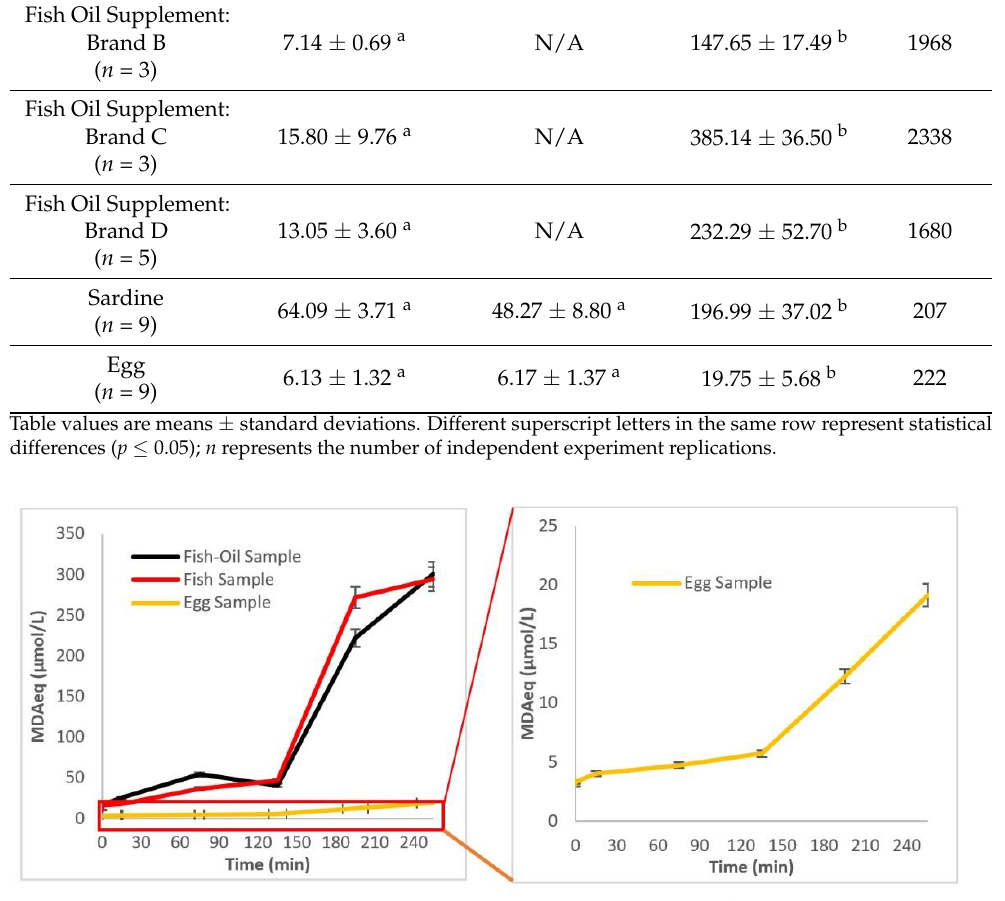
Figure 2. Effect of the GI tract on secondary oxidation of ( a ) fish-oil supplement—Brand D; sardine; fortified egg ( b ) close view—(zoom) on the egg sample.